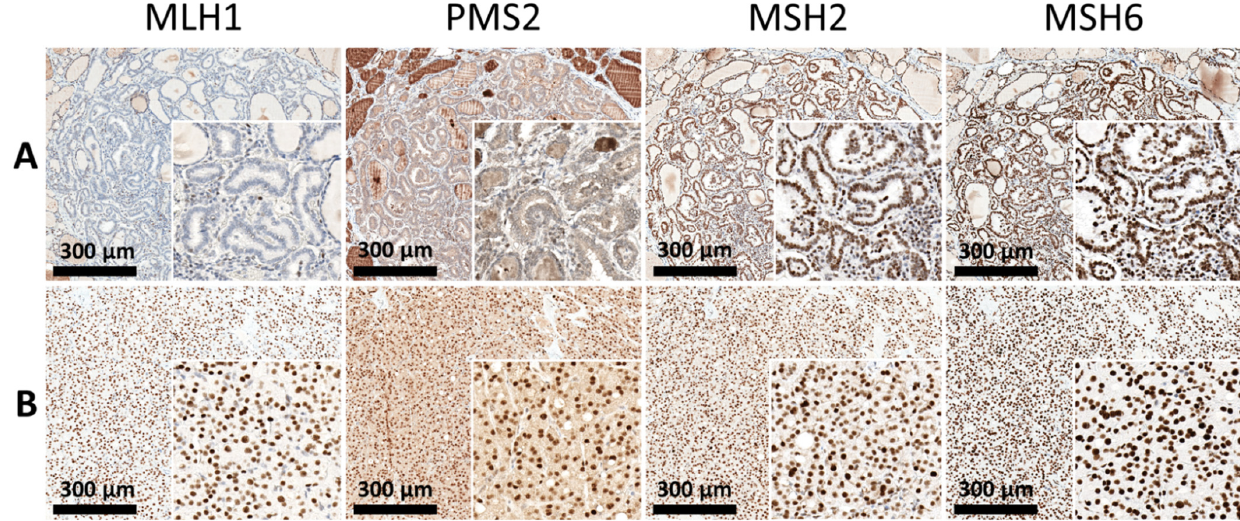
Figure 2. Expression pattern of MMR proteins. Panel ( A ): The tumor sample from papillary carcinoma showed dMMR status with complete loss of nuclear staining for MLH1 and PMS2. Panel ( B ): The tumor sample from follicular carcinoma exhibited an MMR-proficient status with intact nuclear staining for MMR proteins.